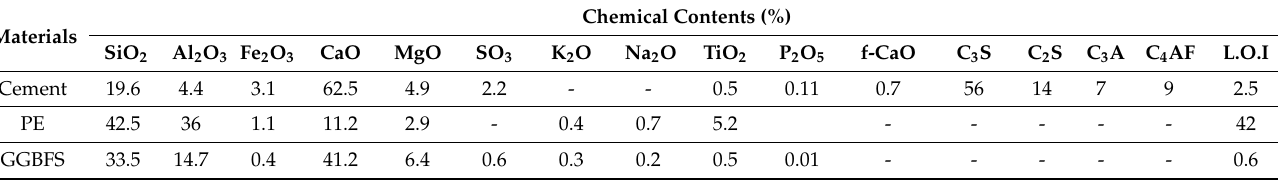
Table 1. Physical properties and chemical composition of test